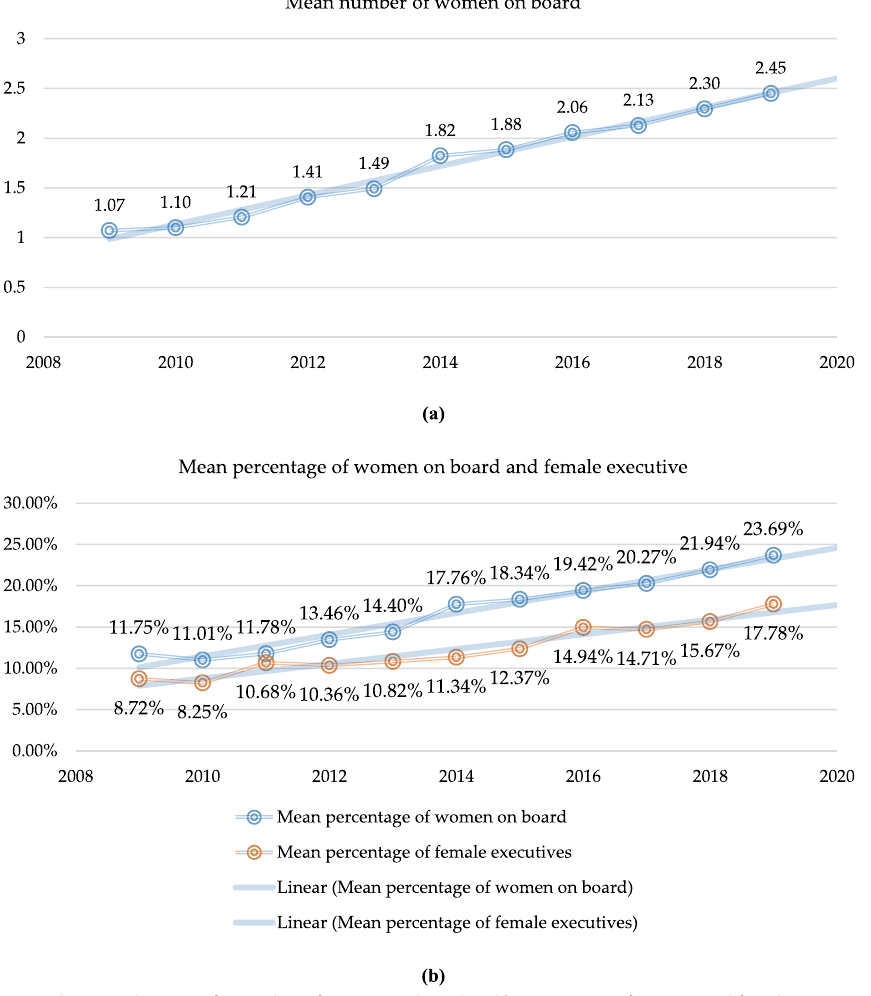
Fig. 1 The annual means of a number of women on board and b percentage of women and female executive on board. Source: Authors’ work